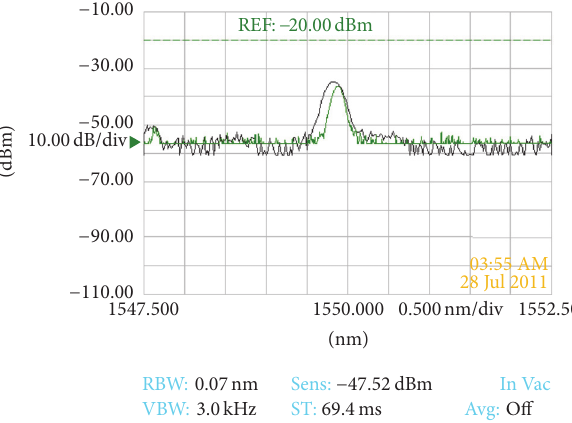
Figure 11: The reflectivity spectrum of the etched-FBG in the air (black line) and the reflectivity spectrum of the same FBG in the deionized water (green line).